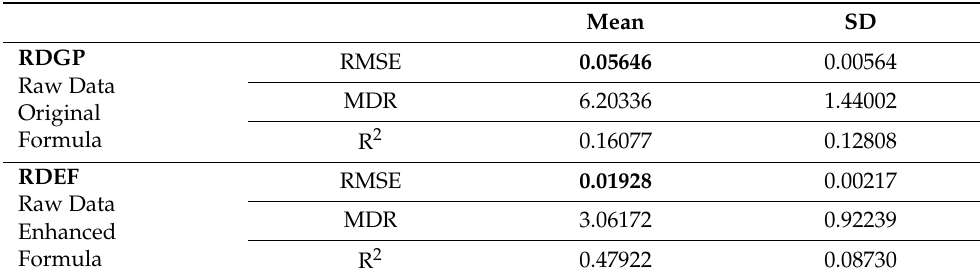
Table 2. Mean and standard deviation of error metrics for raw data and for the out-of-the-bag dataset from bootstrap resampling. RMSE units: kg/(s ·